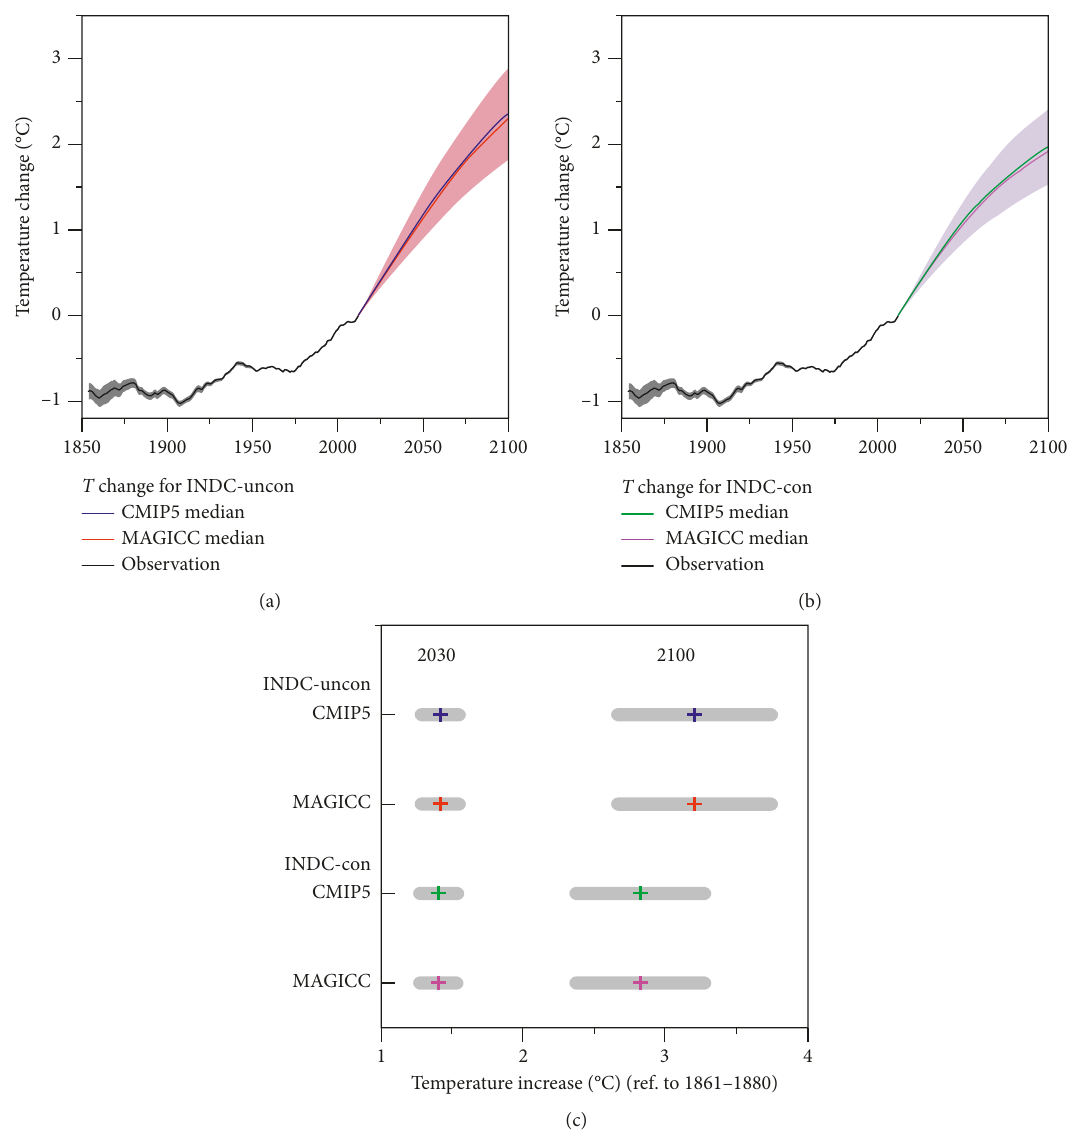
Figure 4: Global temperature increases under Intended Nationally Determined Contribution (INDC) scenarios. (a) unconditional INDC, (b) conditional INDC, and (c) temperature change relative to the preindustrial level (CMIP5: the fifth phase of the Coupled Model Intercomparison Project; MAGICC: Model for the Assessment of Greenhouse Gas Induced Climate Change). The method of calculating temperature response to INDC emissions is presented in Section 2.3. The INDC-induced warming is calculated based on (2) by multiplying Δ T (cumulative carbon emission under the INDC scenarios) by TCRE INDC